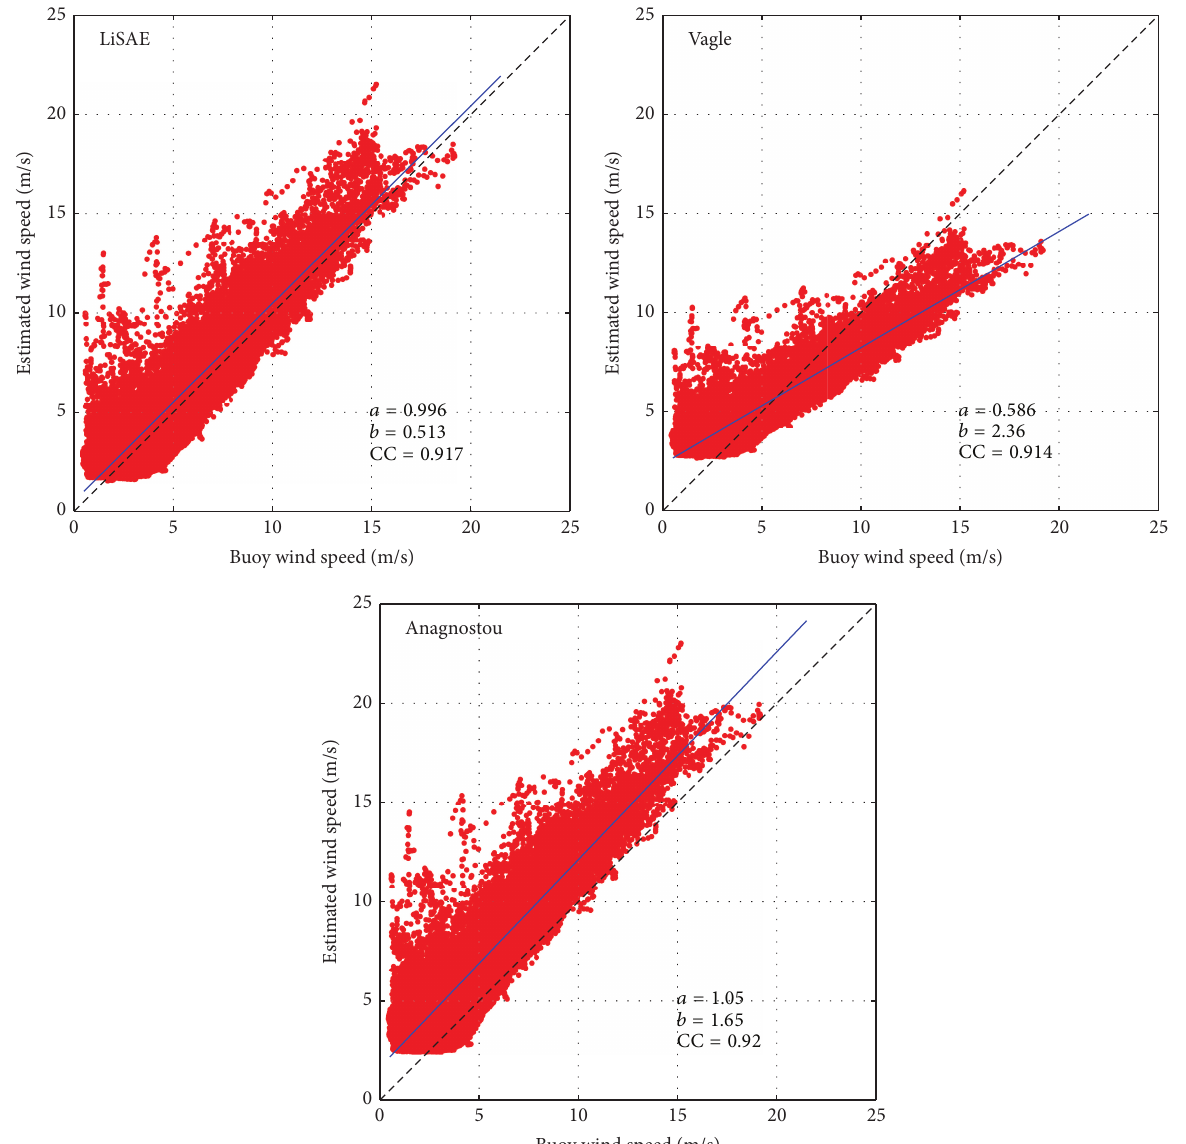
Figure 13: Scatter diagram of estimated versus buoy measured wind speed for three algorithms: LiSAE, Vagle, and Anagnostou, respectively. Dashed lines correspond to the 1: 1 relationship, whereas solid lines are the linear least square fit to the data described by coefficients 𝑎 and 𝑏 . The correlation coefficient is indicated by